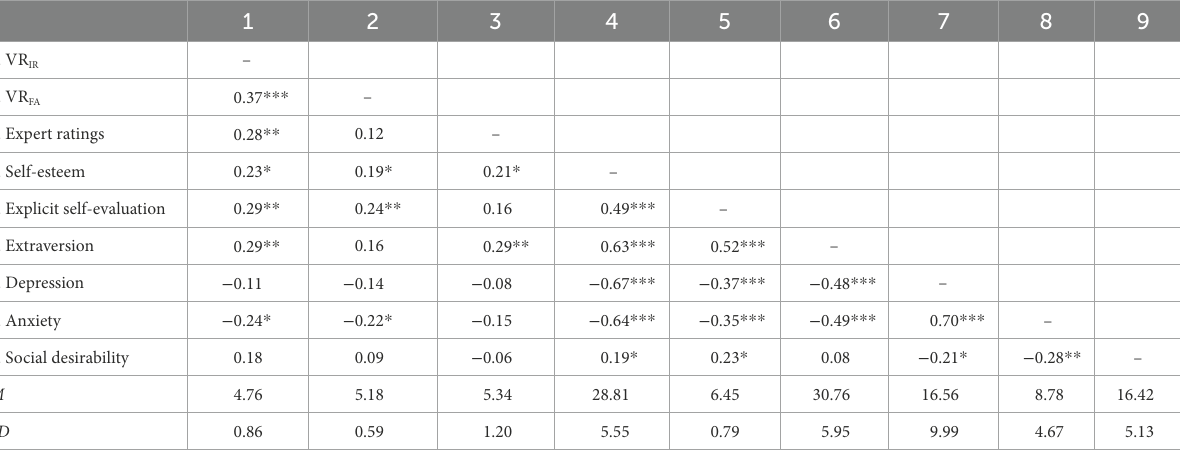
TABLE 1 Descriptive statistics and correlations between study